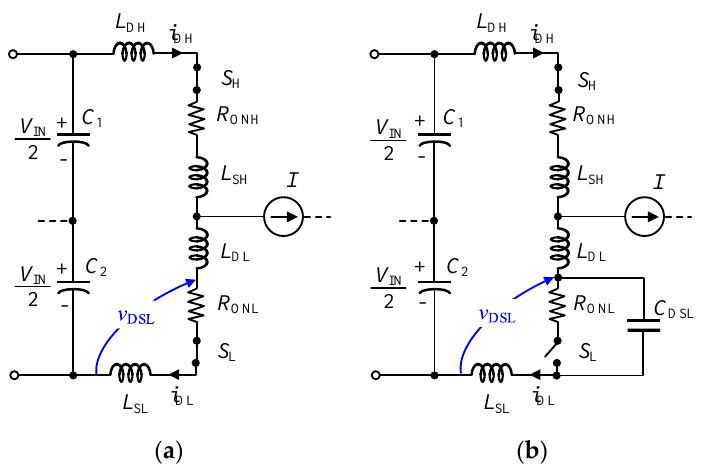
Figure 5. ( a ) Equivalent circuit of the half-bridge converter during overlap conduction ( b ) equivalent circuit when the S L turn-off.